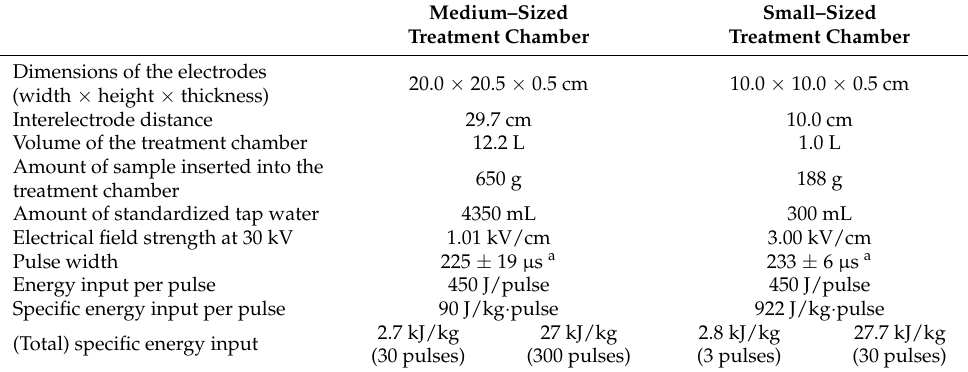
Table 1. Parameter values for the different PEF treatments in each of the used treatment chambers. Medium–Sized Treatment